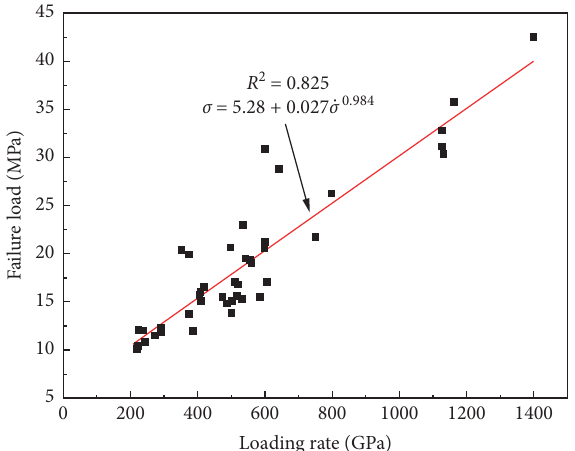
Figure 8: The relationship between the failure load and the loading rate of all the rock